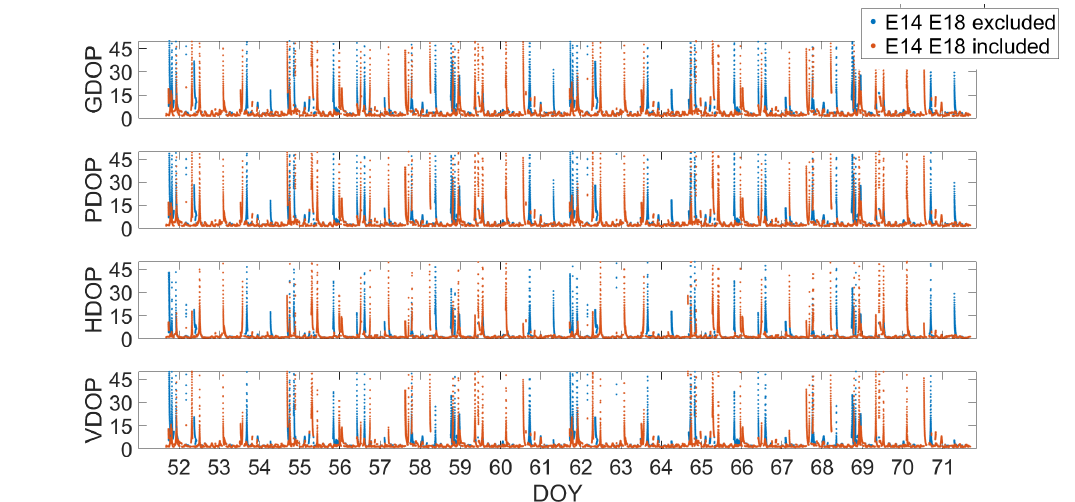
Figure 6. Time evolution of the dilution of precision parameters of the Galileo constellation in the YEL2location. The blue points represent DOP values occurring when the Milena (E14) and Doresa (E18) satellites were excluded. The red points represent DOP values obtained including the Milena (E14) and Doresa (E18) satellites. The ticks on the x axis are spaced 86,400 s (equal to one day); in this way, each tick corresponds to a day.